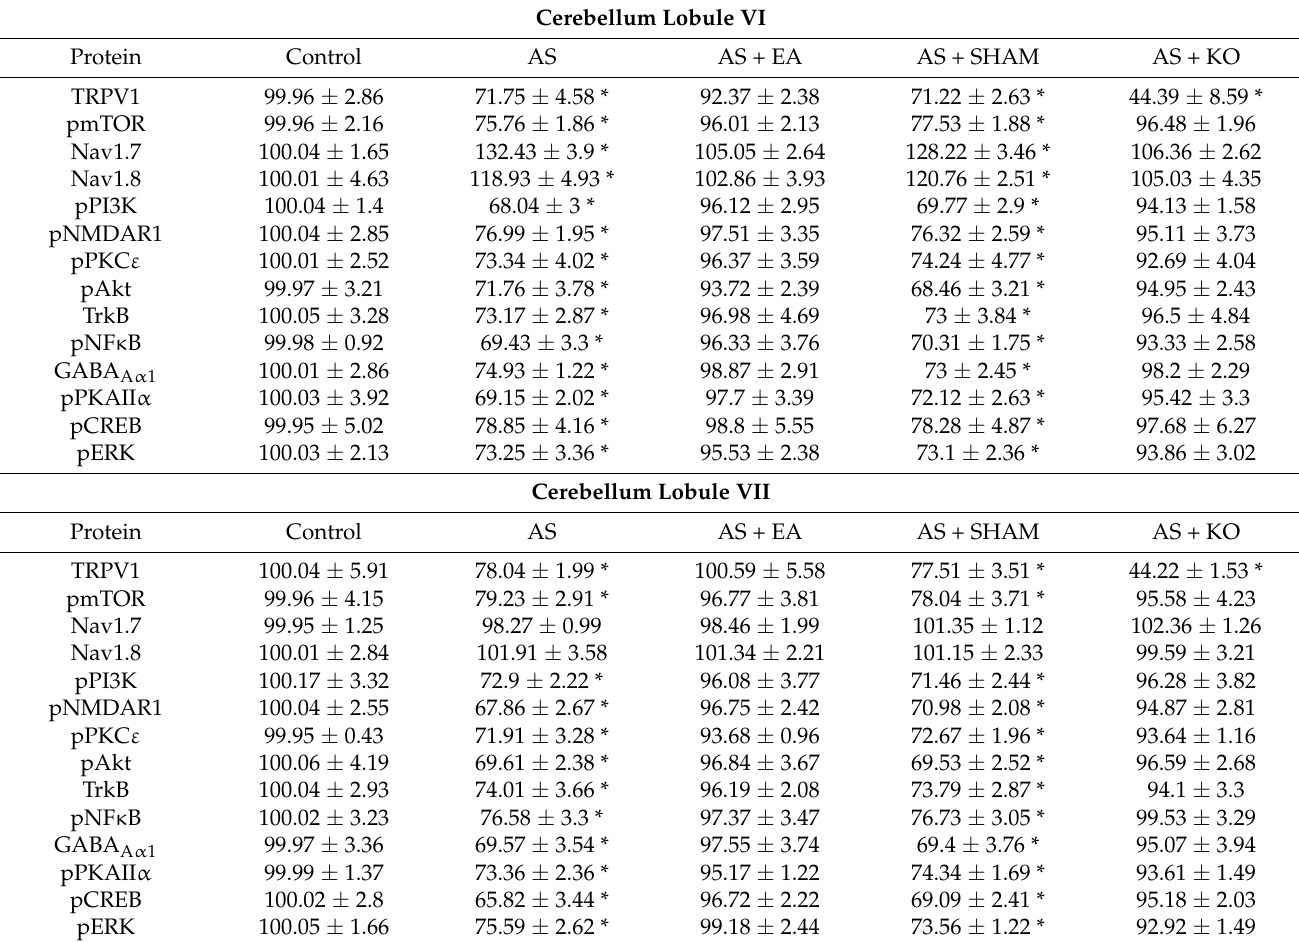
Table 1. Statistical analysis depicting a percentage value of the expression levels of TRPV1-associated signaling pathways and relative proteins within the murine cerebellum lobules VI, VII, and VIII. Statistical Analysis Depicting the Expression Levels of TRPV1-Associated Proteins in the 5 Comparative Groups of an Acid-Saline Induced CPDC